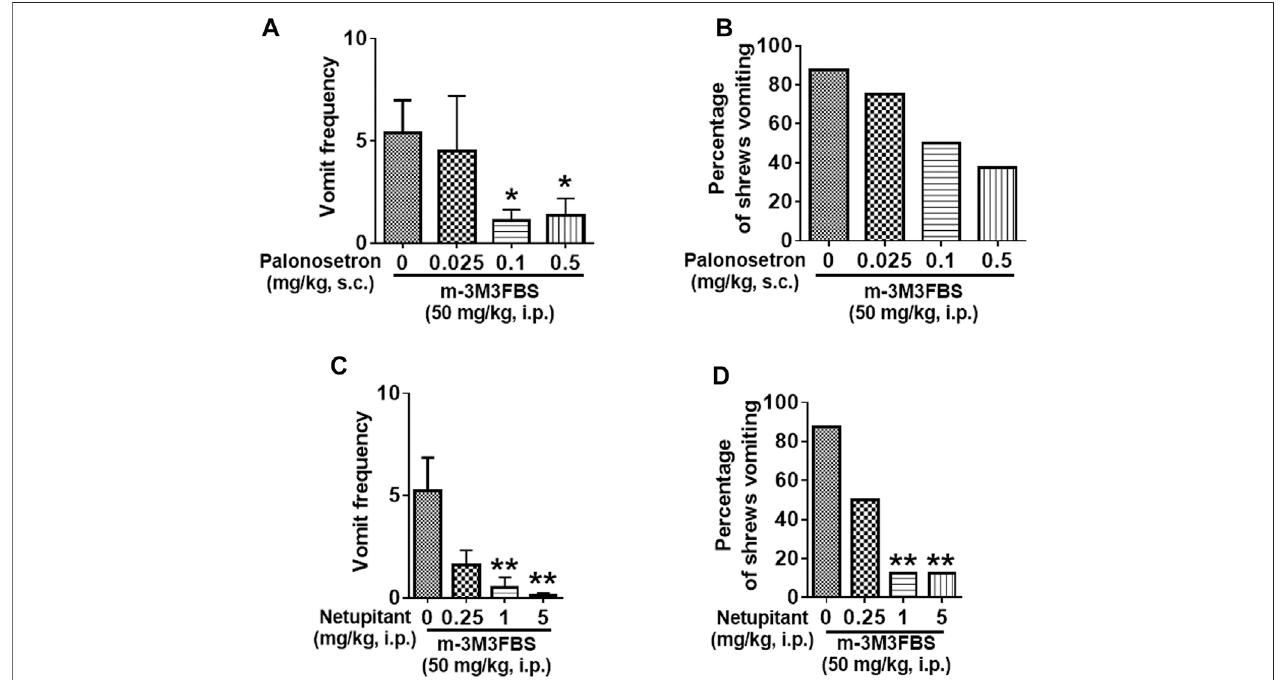
FIGURE7| Theantiemeticeffectsofreceptor-selectiveantagonistsagainstm-3M3FBS-inducedemesis.Differentgroupsofleastshrewsweregivenaninjectionof either the corresponding vehicles (0 mg/kg), or varying doses of the 5-HT 3 R antagonist palonosetron (s.c.) ( n (cid:1) 8 shrews per group) (A,B) , or the neurokinin NK 1 R antagonist netupitant (i.p.) ( n (cid:1) 8) (C,D) , 30 min prior to m-3M3FBS administration (50 mg/kg, i. p.). Emetic parameters were recorded for the next 2 h (A,C) . The frequencyofemesis wasanalyzed withKruskal-Wallisnon-parametricone-wayANOVAfollowedby Dunnett ’ spost hoctest and presented asmean ± SEM. (B,D) Percentage of shrews vomiting was analyzed with chi-square test and presented as mean. * p < 0.05, ** p < 0.01 vs. 0 mg/kg.